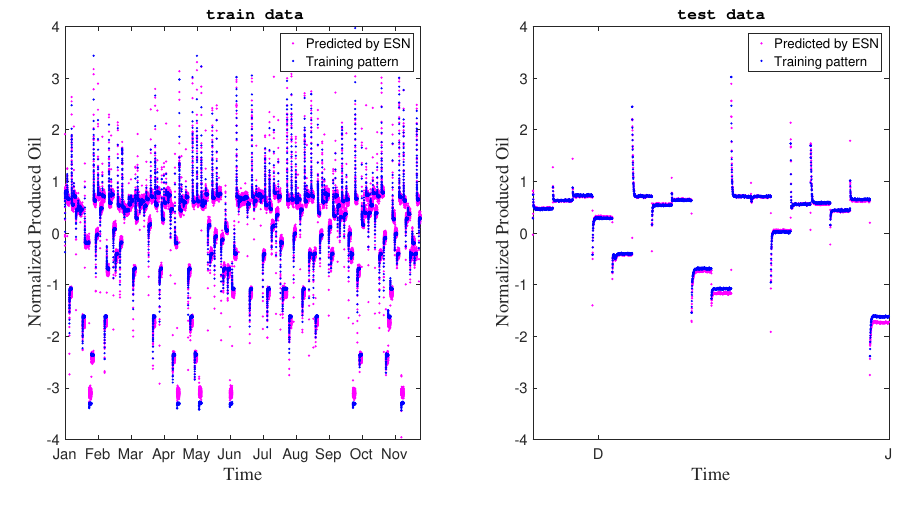
Figure 9. Network training and test. Table 6. Performance Indices for training and